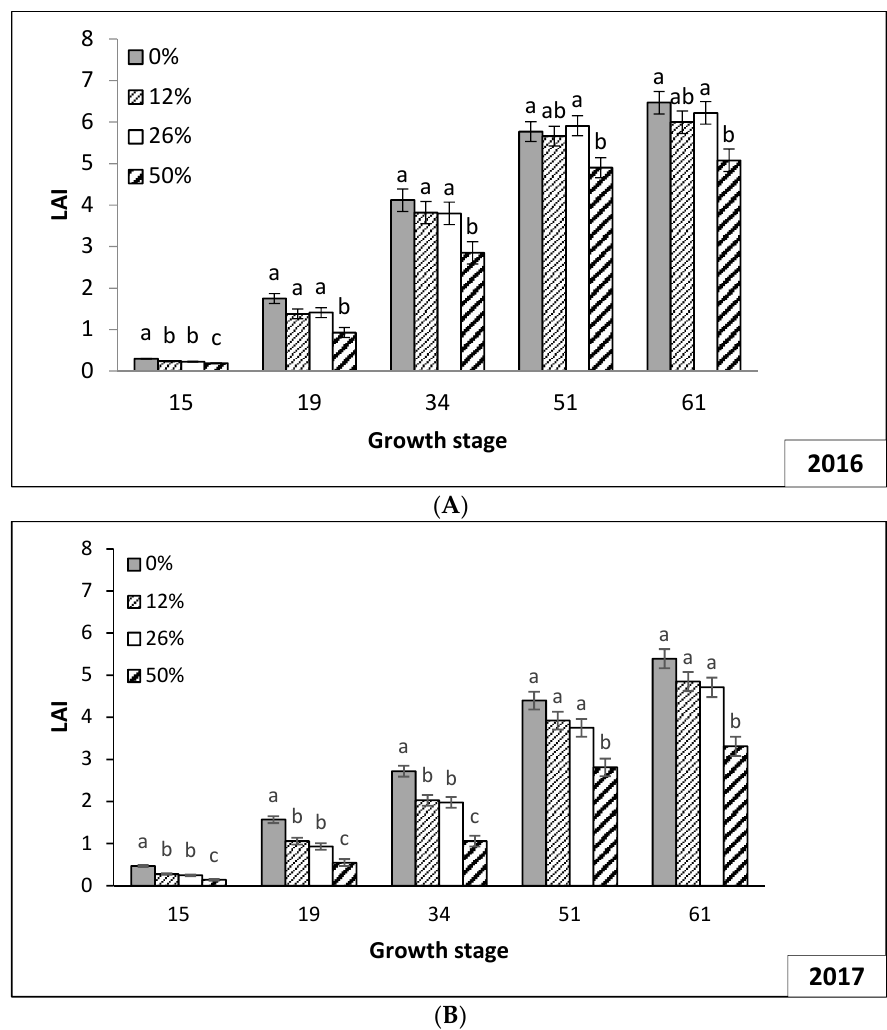
Figure 4. LAI under the different shading levels at the growth stages 15 (5th leaf unfolded), 19 (9th or more leave unfolded), 34 (4 nodes detectable), 51 (tassel initiation), and 61 (silking) of the control in 2016 ( A ) and 2017 ( B ). Black bars represent the standard error of mean. Means with identical letters within a growth stage show non-significant differences between the shade levels (LSD, p < 0.05). Leaf senescence was first observed when the control reached the 8th-leaf stage. In both years, shading delayed senescence from GS 34 onwards (Figure 5). In general, the control had around one senescent leaf more than under 50% shade. In 2017, this effect was less pronounced and high standard errors did not lead to significant differences at GS 51. The high standard errors occurred from the fact, that some of the six observed plants of one plot already did not have any senescent leaf at this time, while other plants in the same plot already had three senescent leaves.